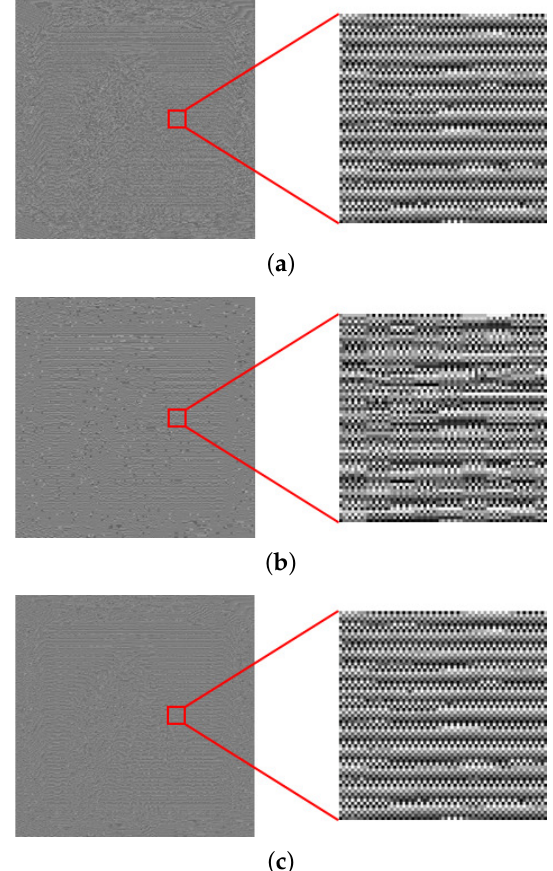
Figure 7. ( a ) Original hologram; ( b ) JPEG compressed hologram; and ( c ) restored hologram with our proposed scheme.